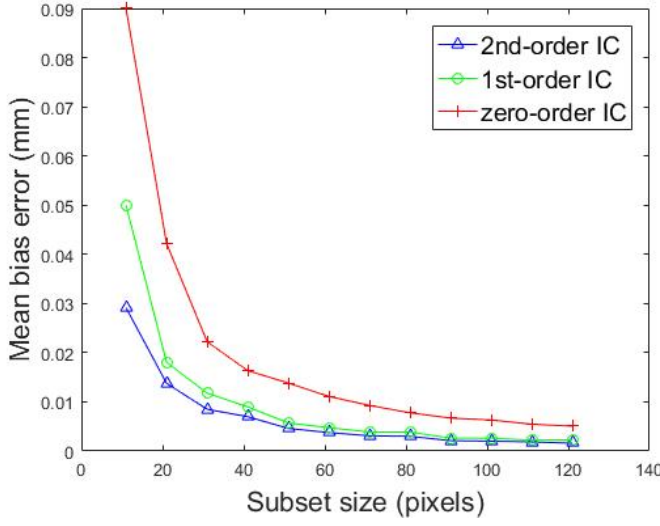
Figure 16. Calculated mean bias errors with di ff erent subset sizes using the DIC method by employing three kinds of shape